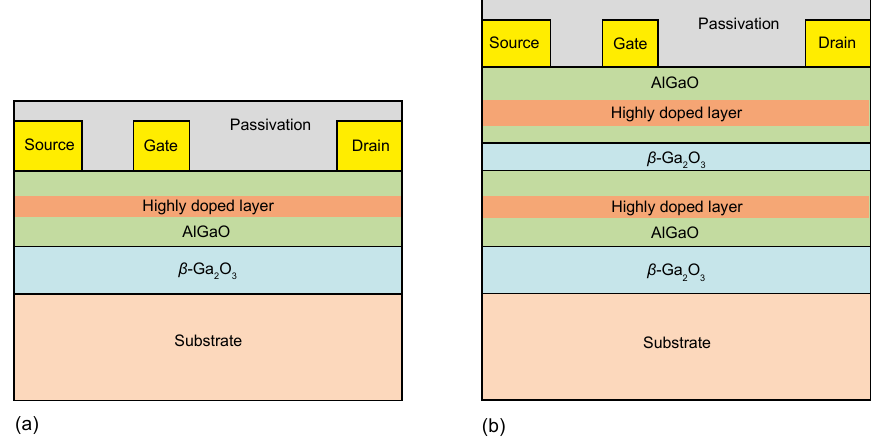
Figure 9. ( a ) Device diagram of β ‐ (Al x Ga 1 − x ) 2 O 3 / β ‐ Ga 2 O 3 FET with delta Si doping in the β ‐ (Al x Ga 1 − x ) 2 O 3 layer. ( b ) β ‐ (Al x Ga 1 − x ) 2 O 3 / β ‐ Ga 2 O 3 FET with double channel.